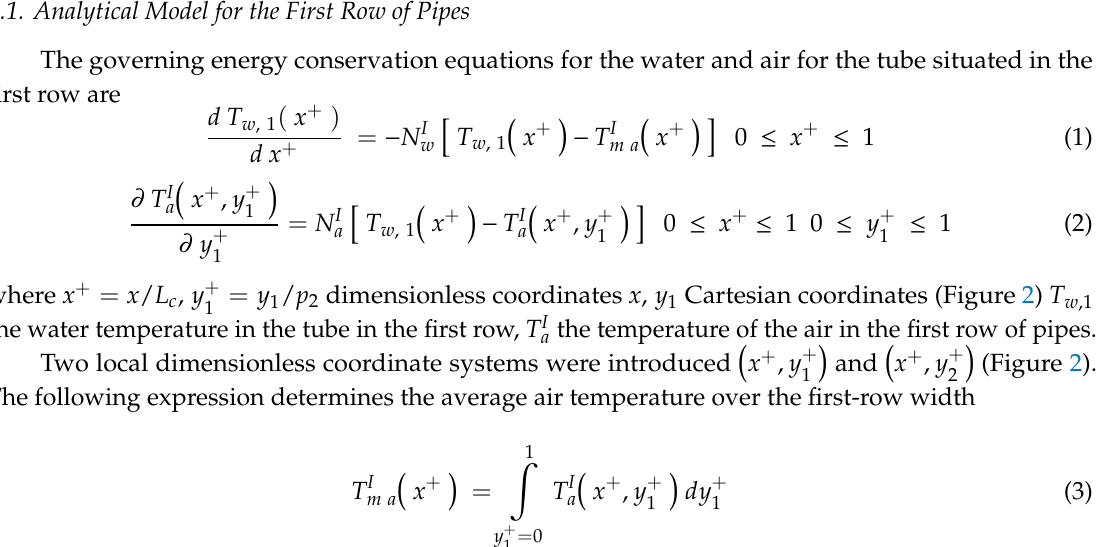
Figure 2. Two rows of tubes in a single-pass heat exchanger.